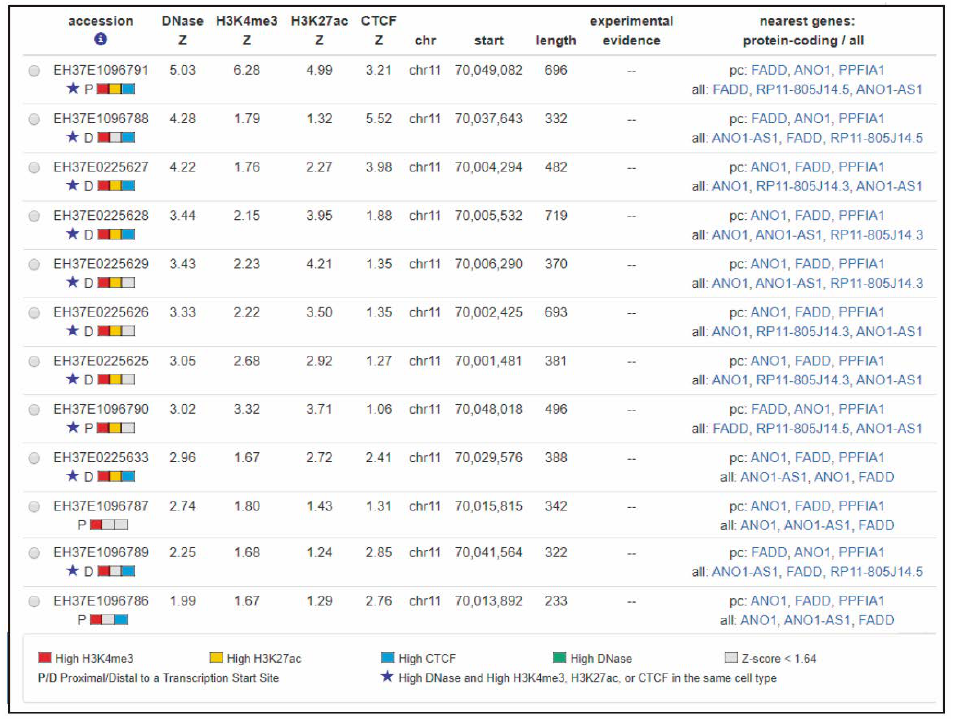
Figure 7. Screenshot image from SCREEN hg19 (search candidate cis-regulatory elements by ENCODE). This search is showing candidate cis-regulatory elements located between the first and last transcription start sites (TSSs) of FADD and up to 50 kb upstream.